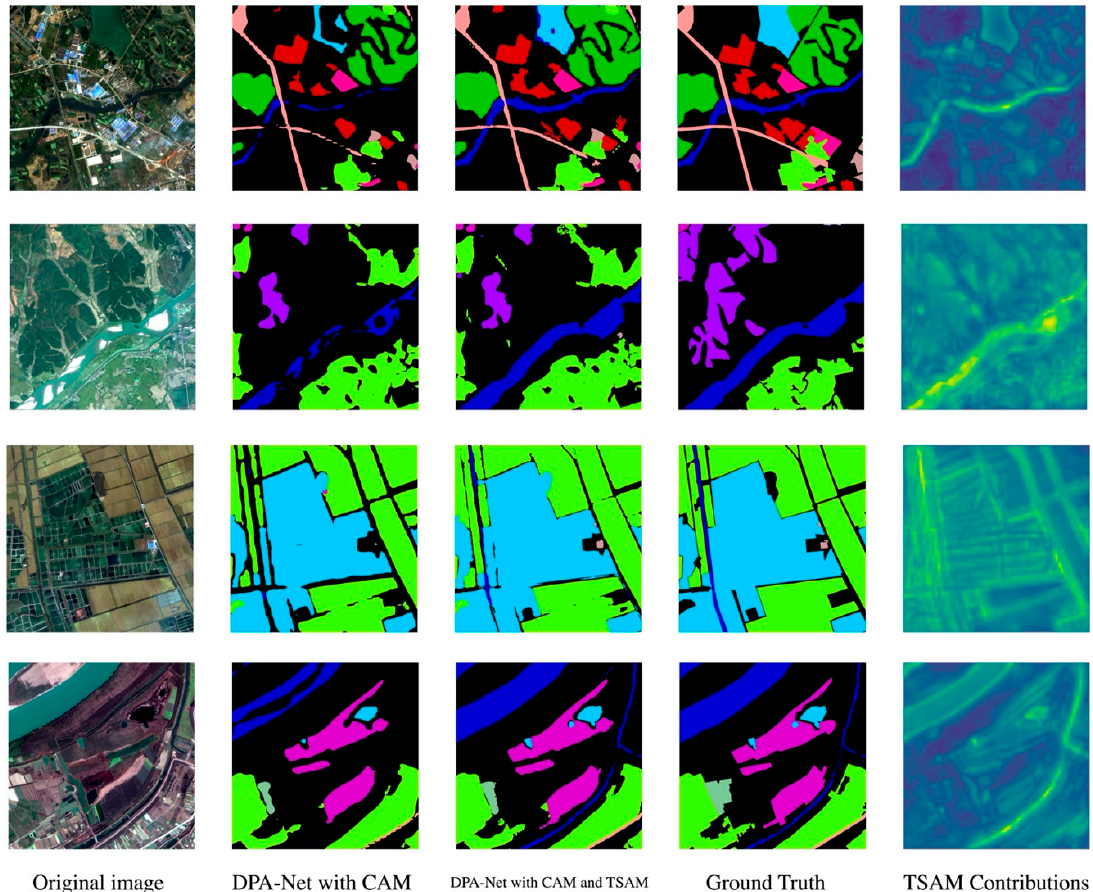
Figure 10. Visual performance of DPA-Net on the GID dataset with and without TSAM.